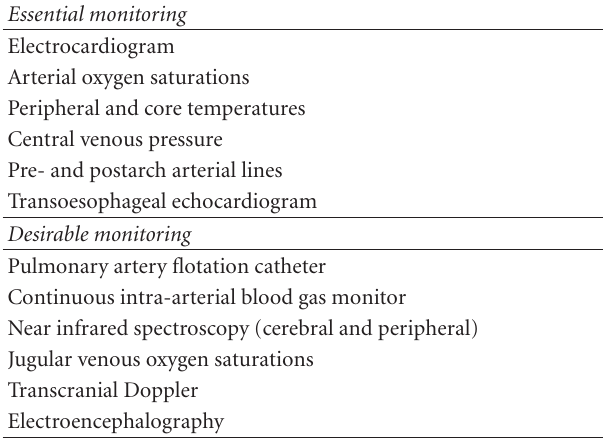
Table 1: Essential and desirable monitoring techniques for use in repair of acute type A aortic dissection.